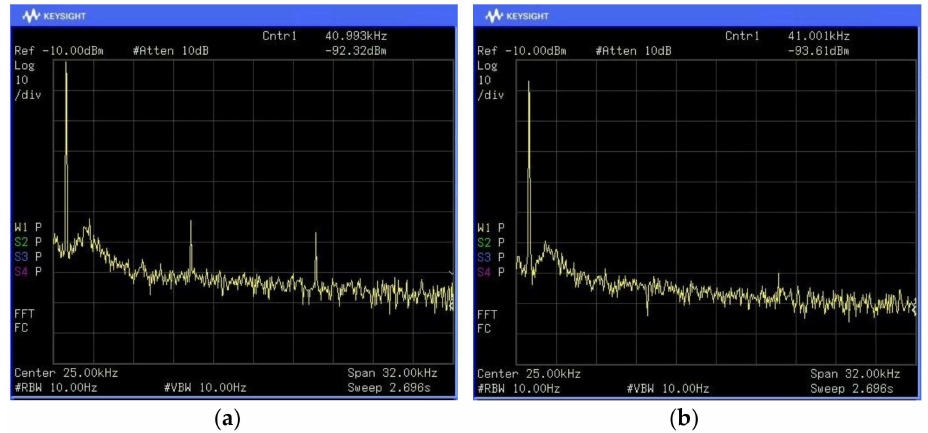
Figure 13. Test result of 10 KHz sine wave. ( a ) Signal before filter. ( b ) Signal after filter.